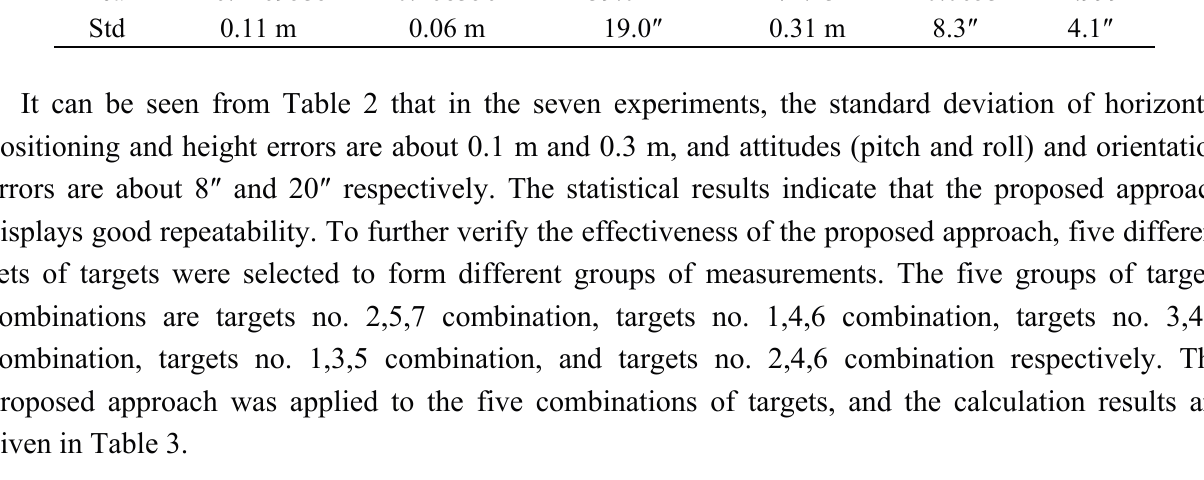
Table 3. Positioning and orientation results using different combination of targets Targets